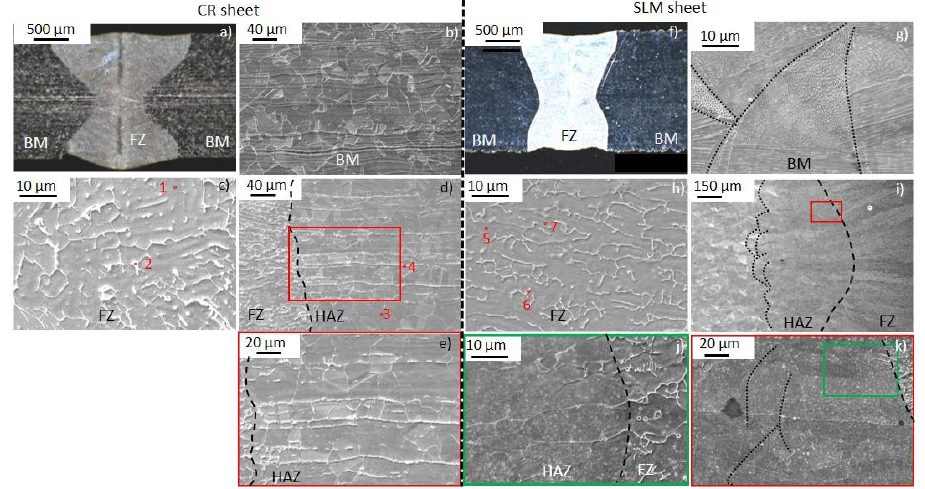
Figure 3. Welded cold-rolled sheets: macrography of the weld seam ( a ); higher magnification of base metal (BM) ( b ); fusion zone—heat-affected zone (HAZ) boundary ( d , e ) and fusion zone (FZ) ( c ); welded SLM sheets: macrography of the weld seam ( f ); higher magnification of base metal (BM) ( g ); fusion zone—heat-affected zone (HAZ) boundary ( i – k ) and fusion zone (FZ) ( h ). Dashed lines correspond to fusion zone boundaries. Dotted lines correspond to melt pool boundaries. Red dots correspond to SEM-EDX point analysis positions. Table 5. Seam geometrical description.